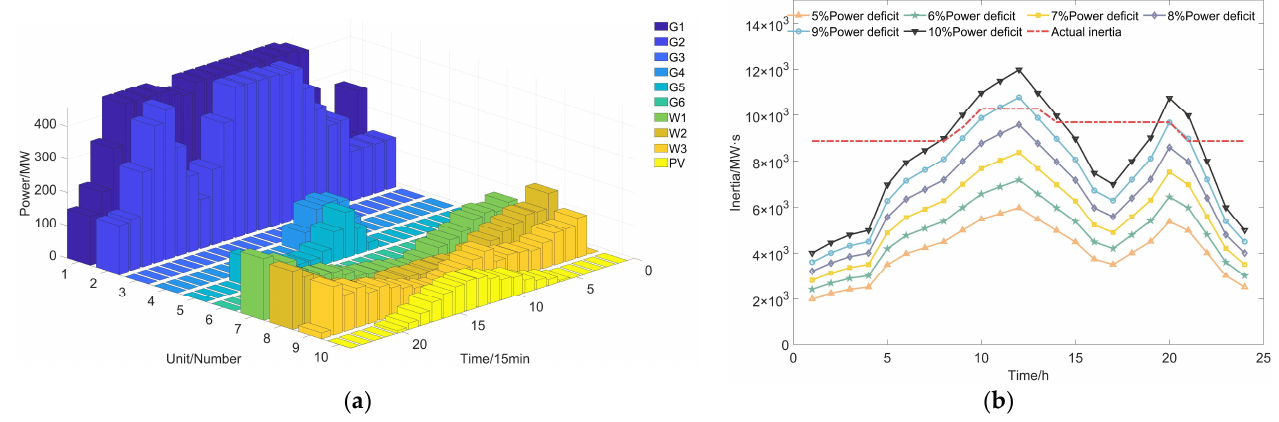
Figure 3. ( a ) Results for day-ahead scheduling. ( b ) Inertia demand for different power deficits in the day-ahead scheduling period.